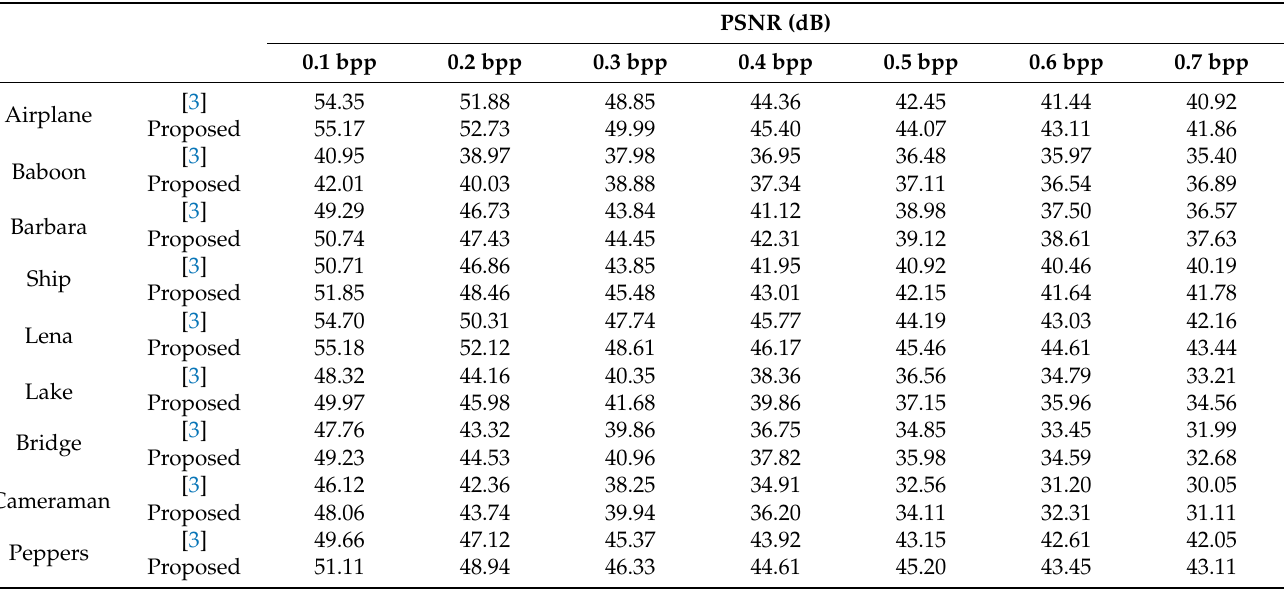
Table 4. Comparison of the PSNR (dB) value single-layer embedding in terms of visual quality test images.